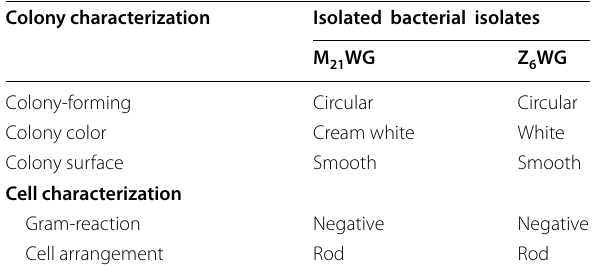
Table 2 Morphological and cultural characters of the most efficient bacterial isolates, M Colony characterization Isolated bacterial isolates